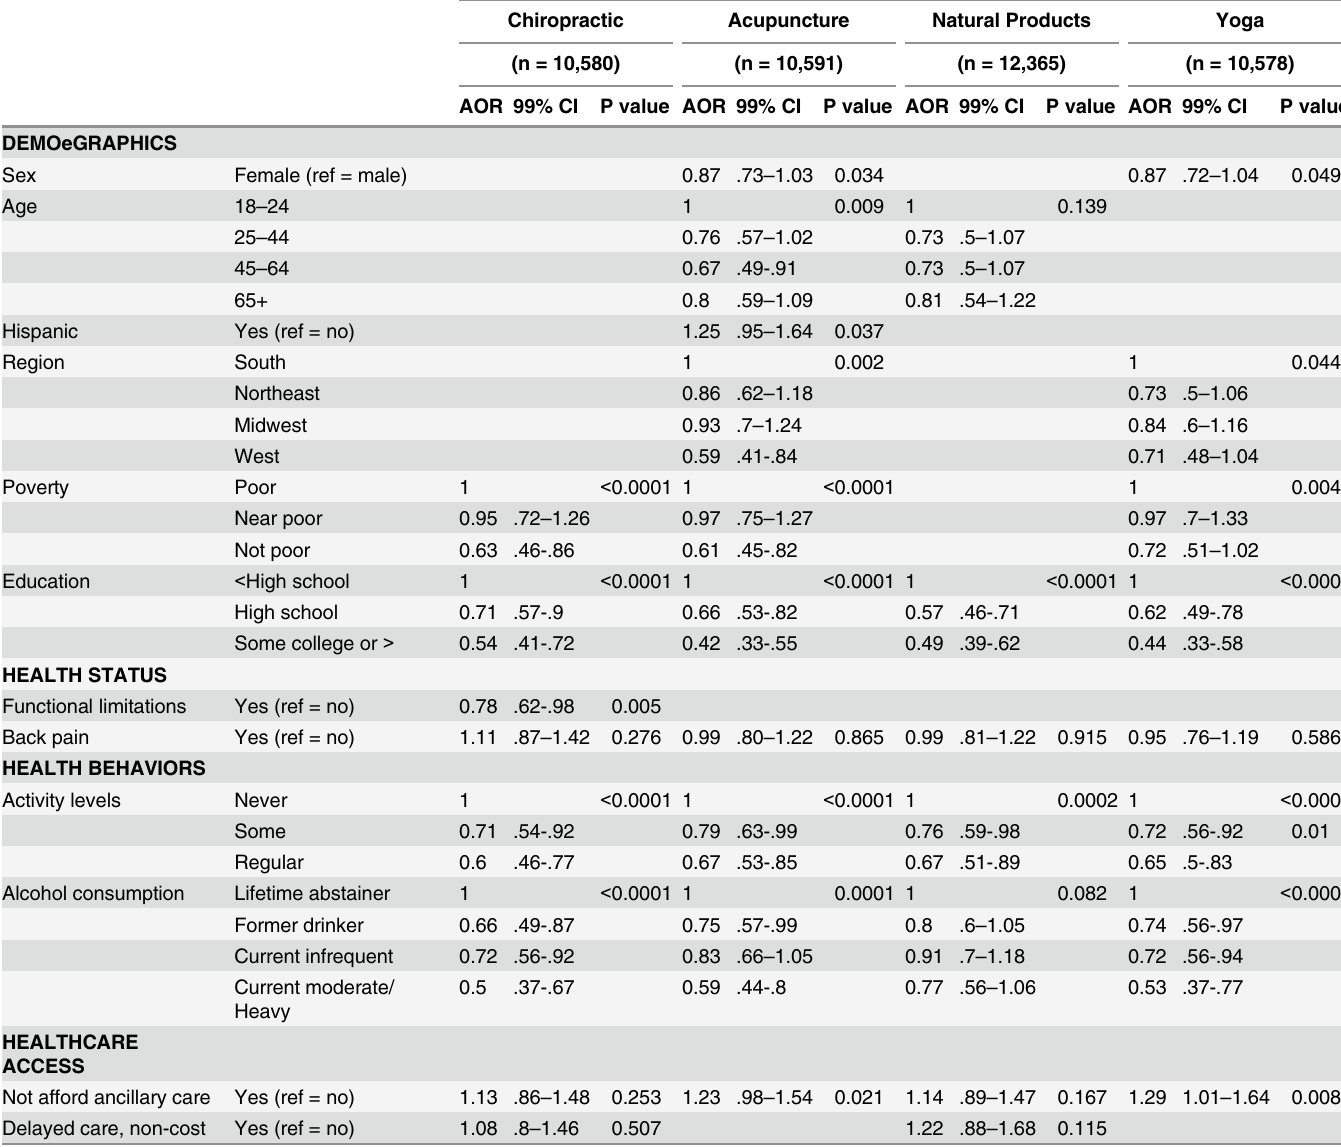
Table 2. Adjusted odds ratios and 99% confidence interval estimates of items independently associated with choosing 'lack of knowledge' as a reason for non-use of four complementary health practices, full